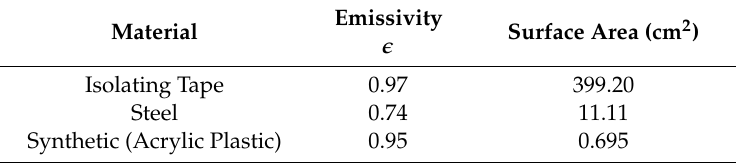
Table 5. The parameter list of the surface-related thermo-physical properties.